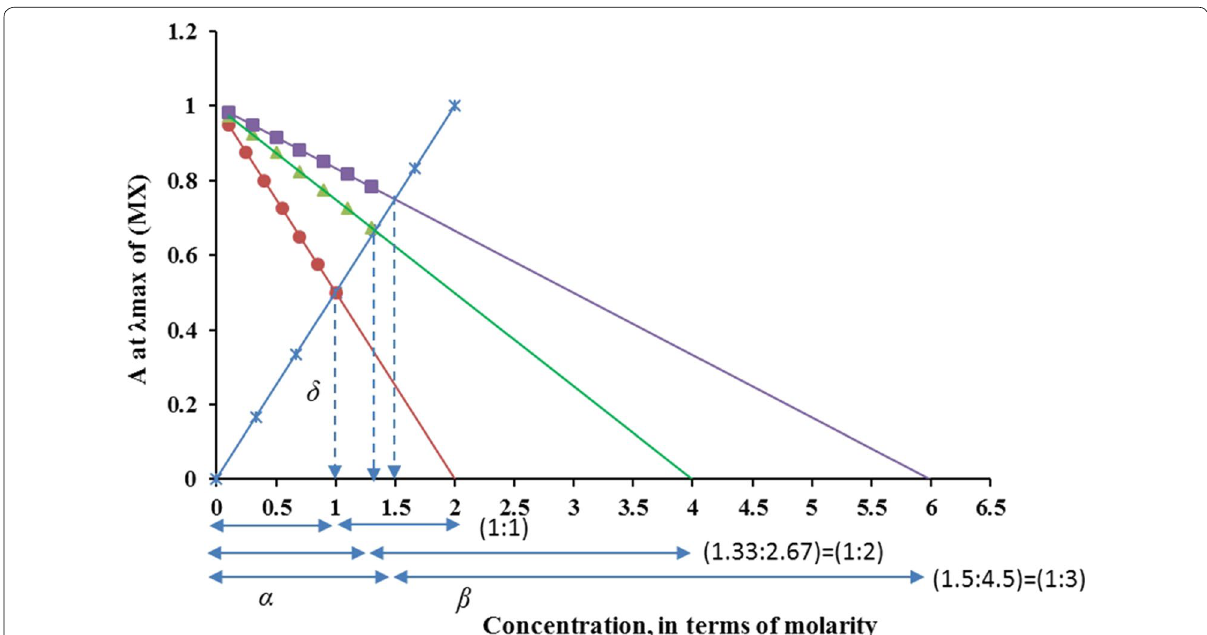
Fig. 1 Illustrative plots of the ligand exchange method using MX as an initial complex (*) for studying the mole ratios of complexes: ML ( ● ), ML 2 ( ▲ ), and ML 3 ( ■